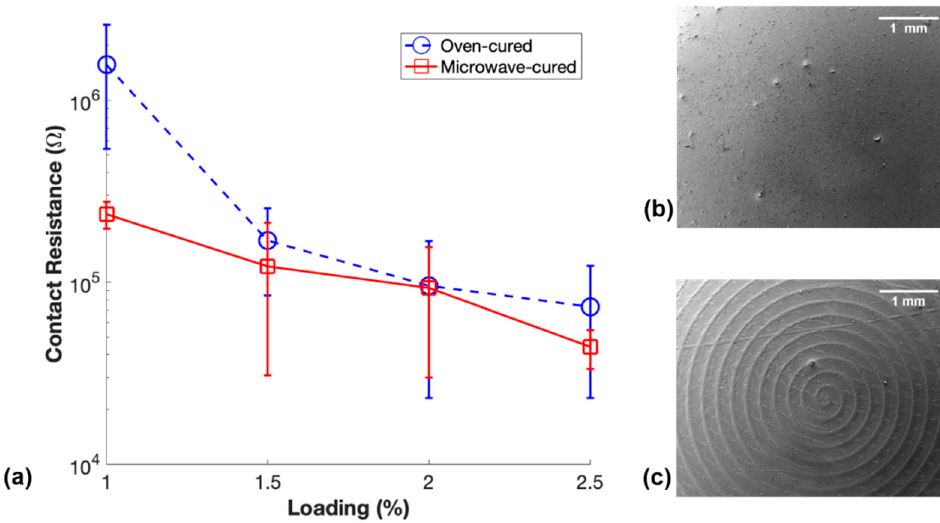
Figure 6. ( a ) Contact resistance of m-PDMS / CNT and t-PDMS / CNT for each conductive loading, ( b ) SEM image of m-PDMS / CNT surface cured in contact with glass mold, and ( c ) SEM image of t-PDMS / CNT cured in contact with aluminum mold.